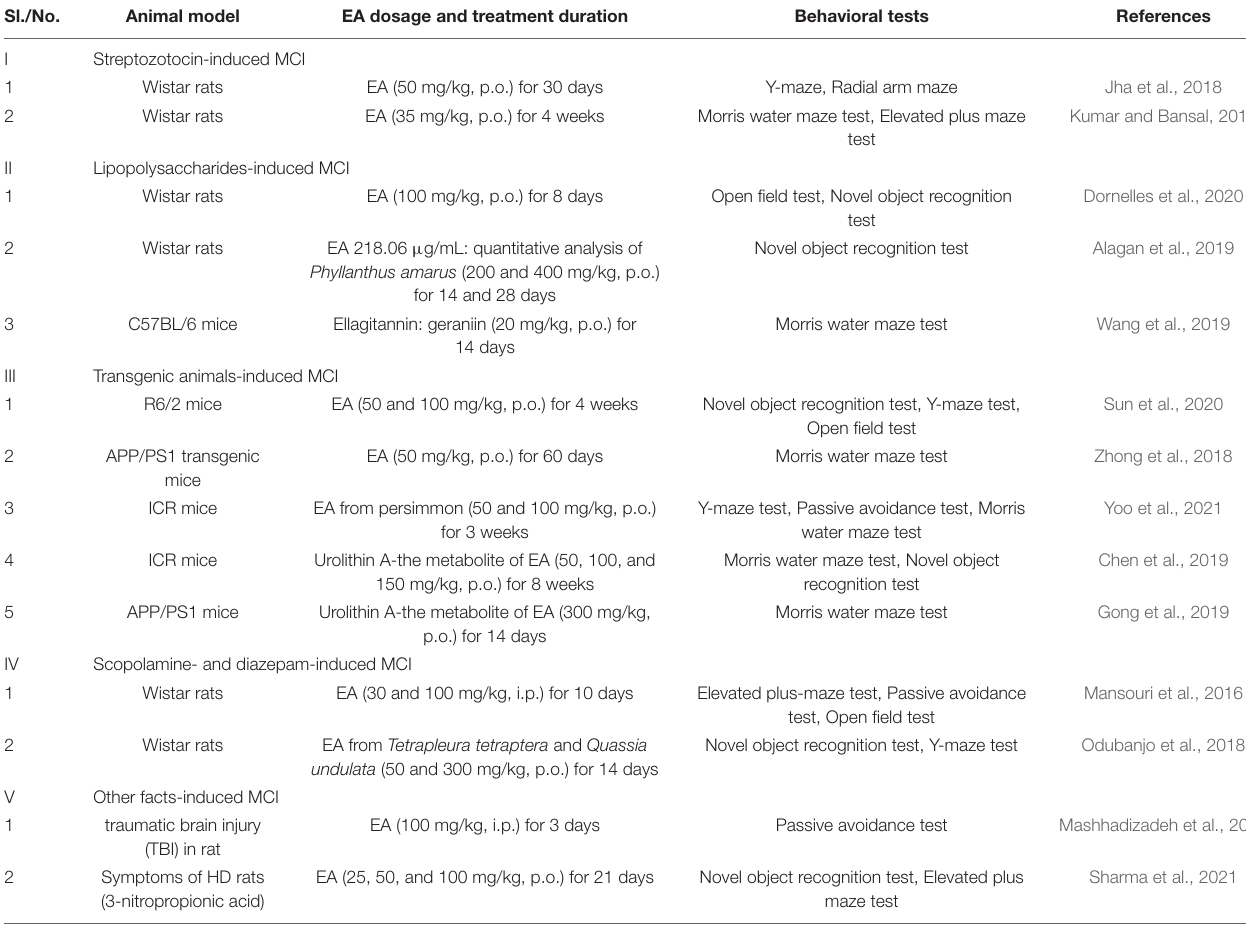
TABLE 3 | Animal behavioral tests representing the effects of ellagic acid (EA) against mild cognitive impairment (MCI).